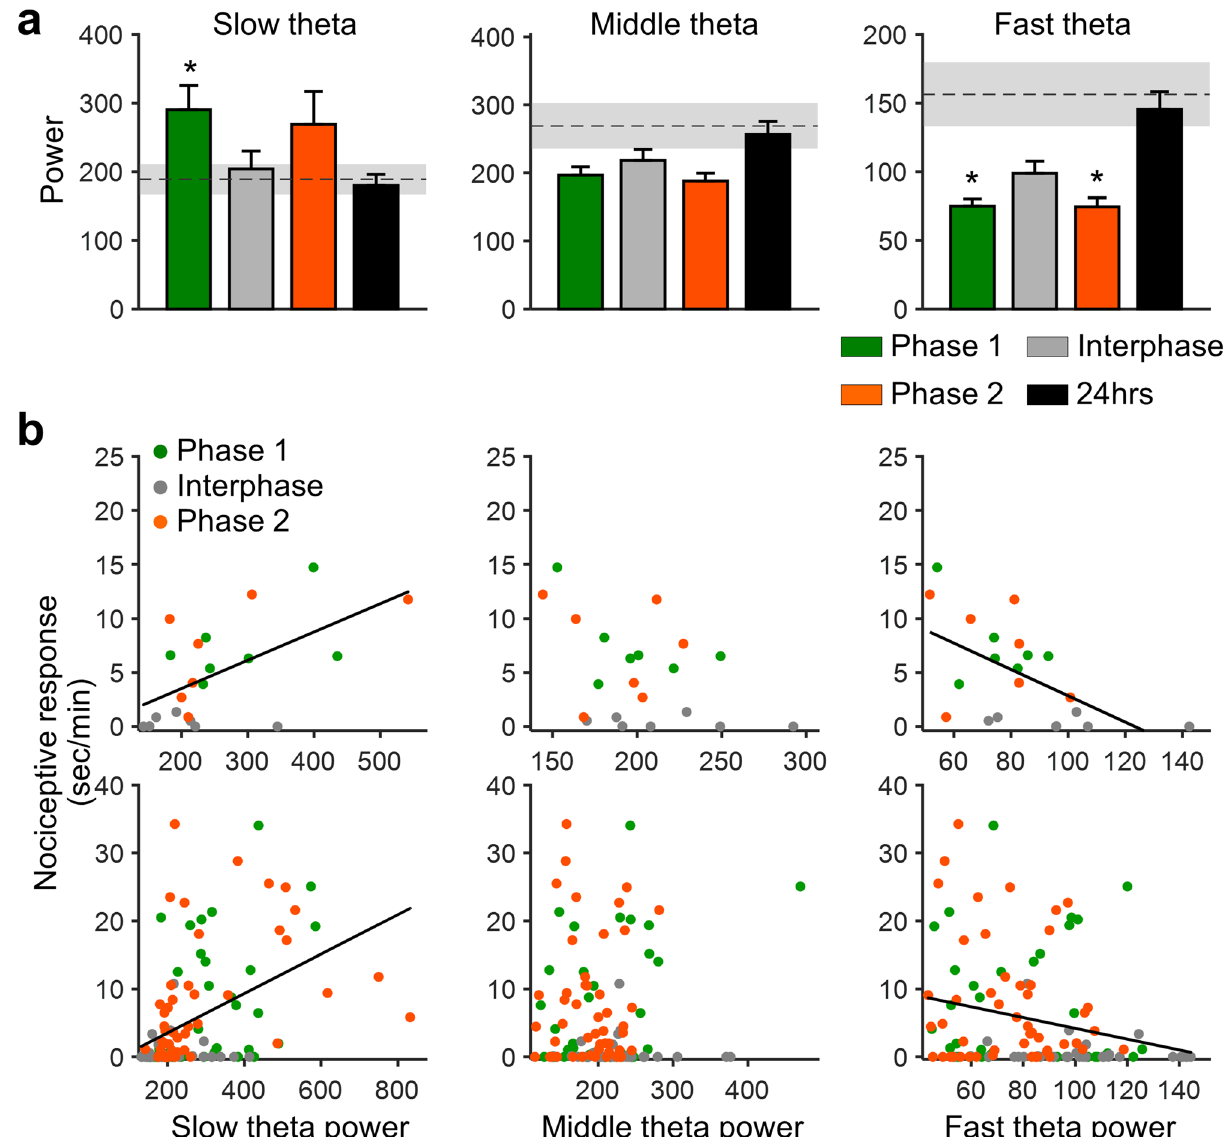
Figure 4. Nociceptive response positively and negatively correlates with slow and fast theta power, respectively. ( a ) Mean power in slow (4–7 Hz), middle (7–9 Hz), and fast (9–12 Hz) theta-range oscillations after formalin injection. The dashed lines and shaded areas indicate the mean and SEM at baseline, respectively. The noxious stimulus increased and decreased slow and fast theta power, respectively, during the nociceptive phases. ( b ) Scatter plots depicting nociceptive response plotted against theta power. Top: individual phases in individual animals. Bottom: values binned by time (2 min). There was a significant positive and negative correlation of nociceptive response with slow theta power (individual phases: R = 0.58, P = 0.0055; time-binned values: R = 0.45, P = 0.00000030) and fast theta power (individual phases: R = − 0.56, P = 0.0081; time-binned values: R = − 0.24, P = 0.0086), respectively. Individual phases: R = − 0.42, P = 0.061; time-binned values: R = 0.070, P = 0.44 for middle theta power. Data are presented as mean ± SEM; *P < 0.05 vs. baseline values; repeated measures ANOVA with a post hoc Dunnett’s multiple comparison